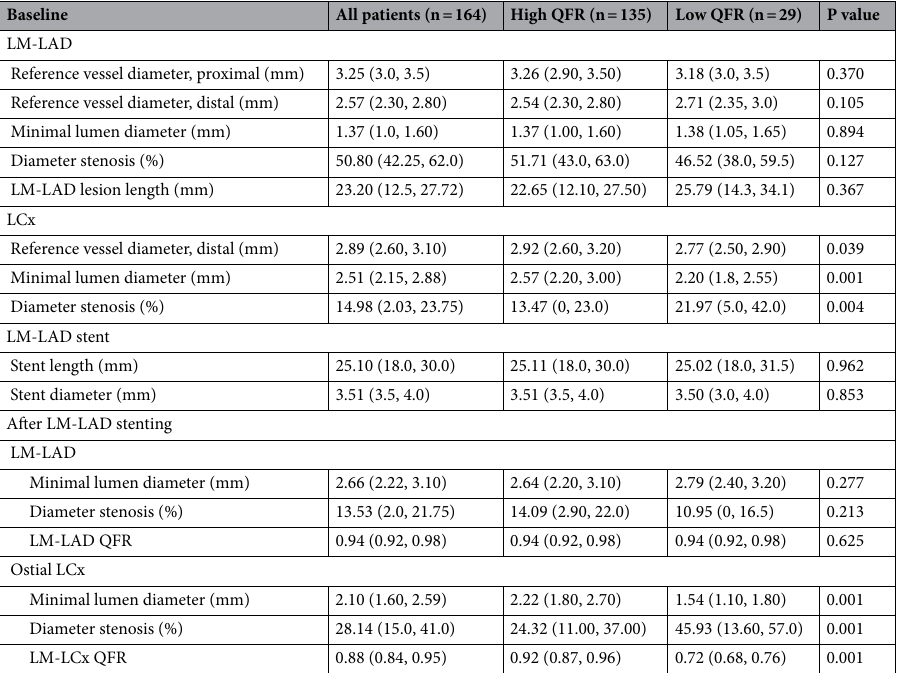
Table 2. Lesion and procedural details.